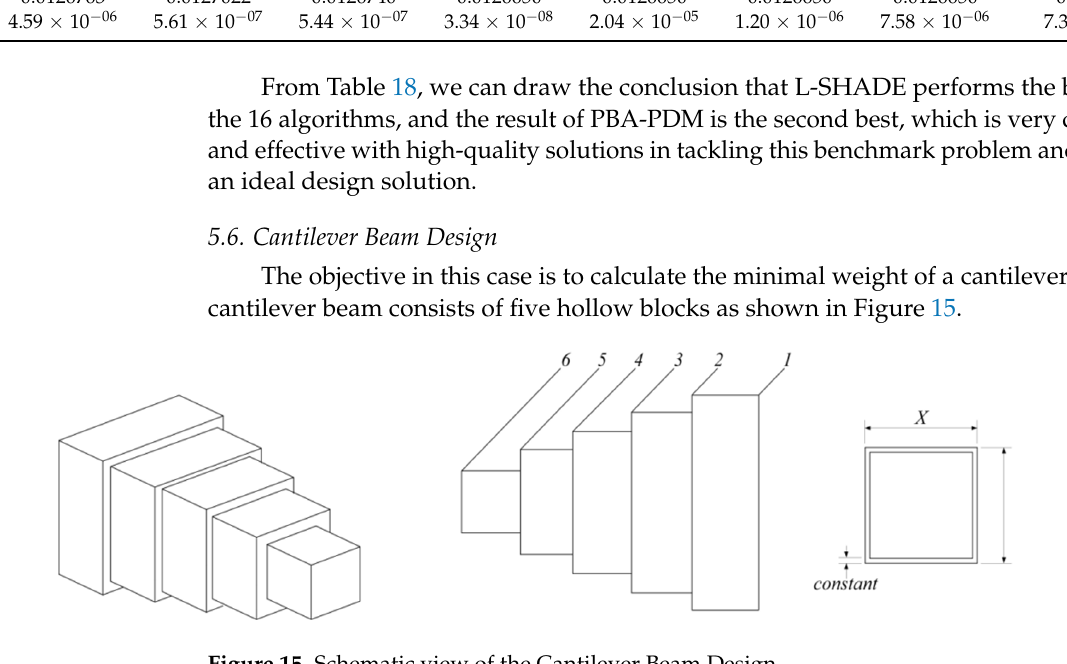
Figure 15. Schematic view of the Cantilever Beam Design.